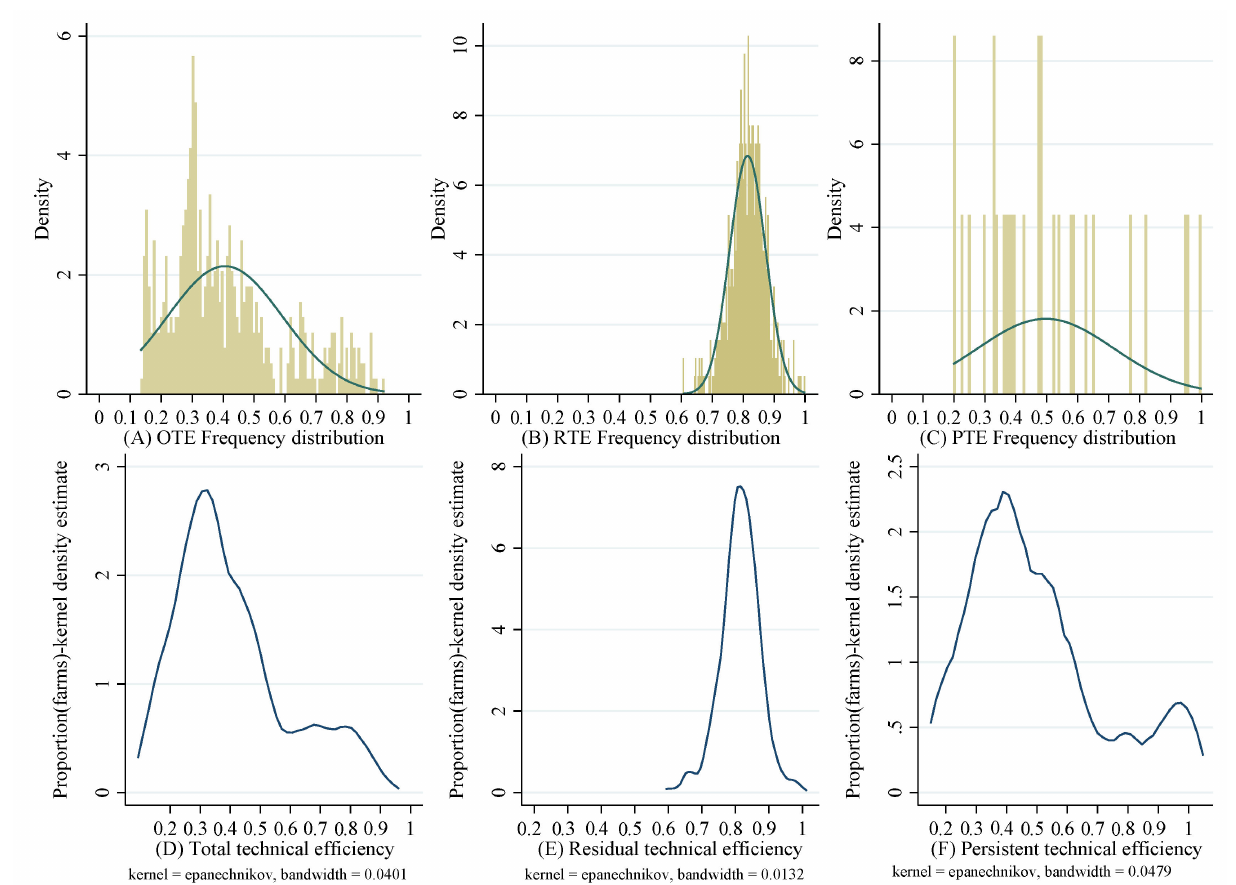
Figure 2. The model used in this paper to estimate China’s energy industrial chain technology efficiency TE and its decomposition efficiency RTE and PTE . Note: OTE = TE ( A ), RTE ( B ), and PTE ( C ) denote quantile frequency change and data distribution; OTE ( D ), RTE ( E ), and PTE ( F ) denote nuclear density